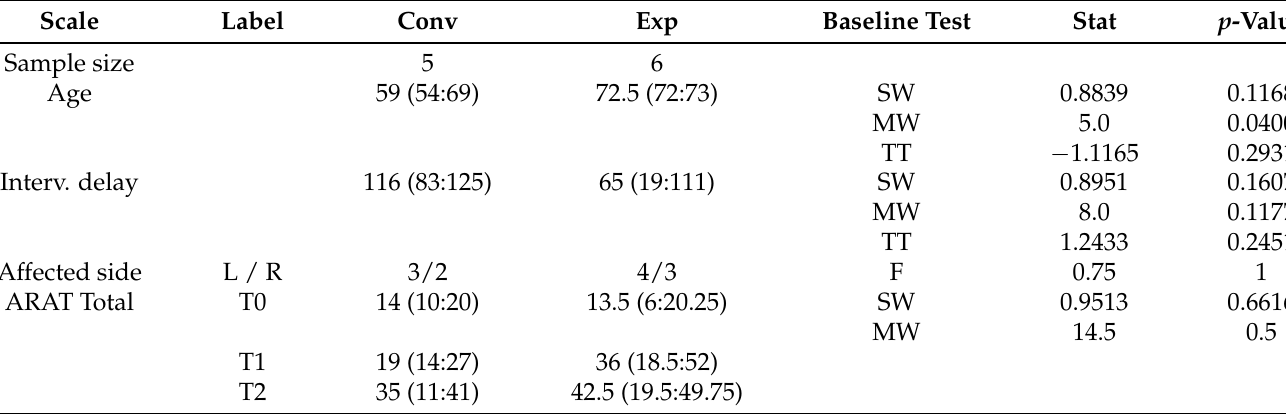
Table 2. Descriptive statistics of the interim analysis. SW: Shapiro Wilk. MW:MannWhitney. TT: T -test. F: Fisher exact test.